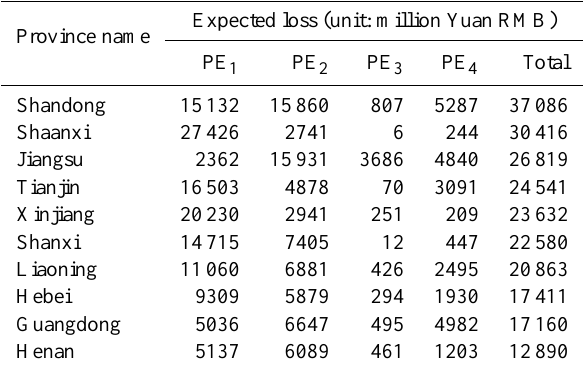
Table 6. The top 10 expected loss of earthquake fire for